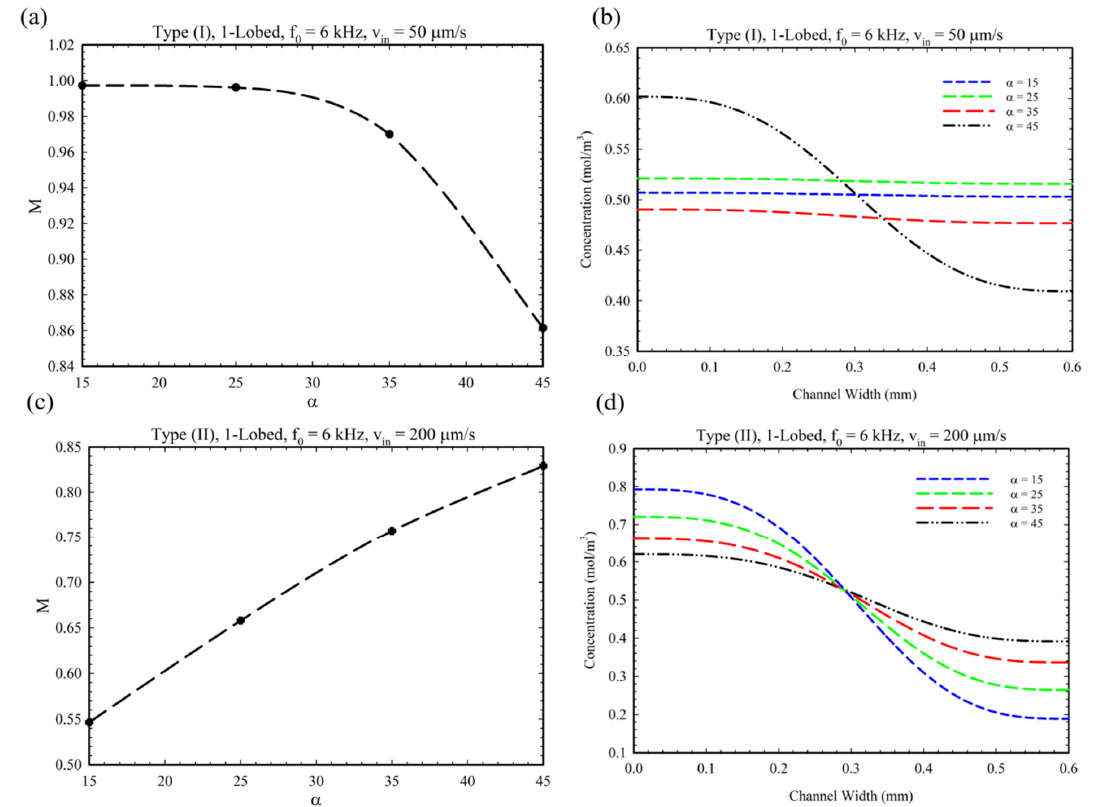
Figure 3. MI and concentration profiles for different 𝛼 values: ( a , b ) Type I and ( c , d ) Type II configuration.